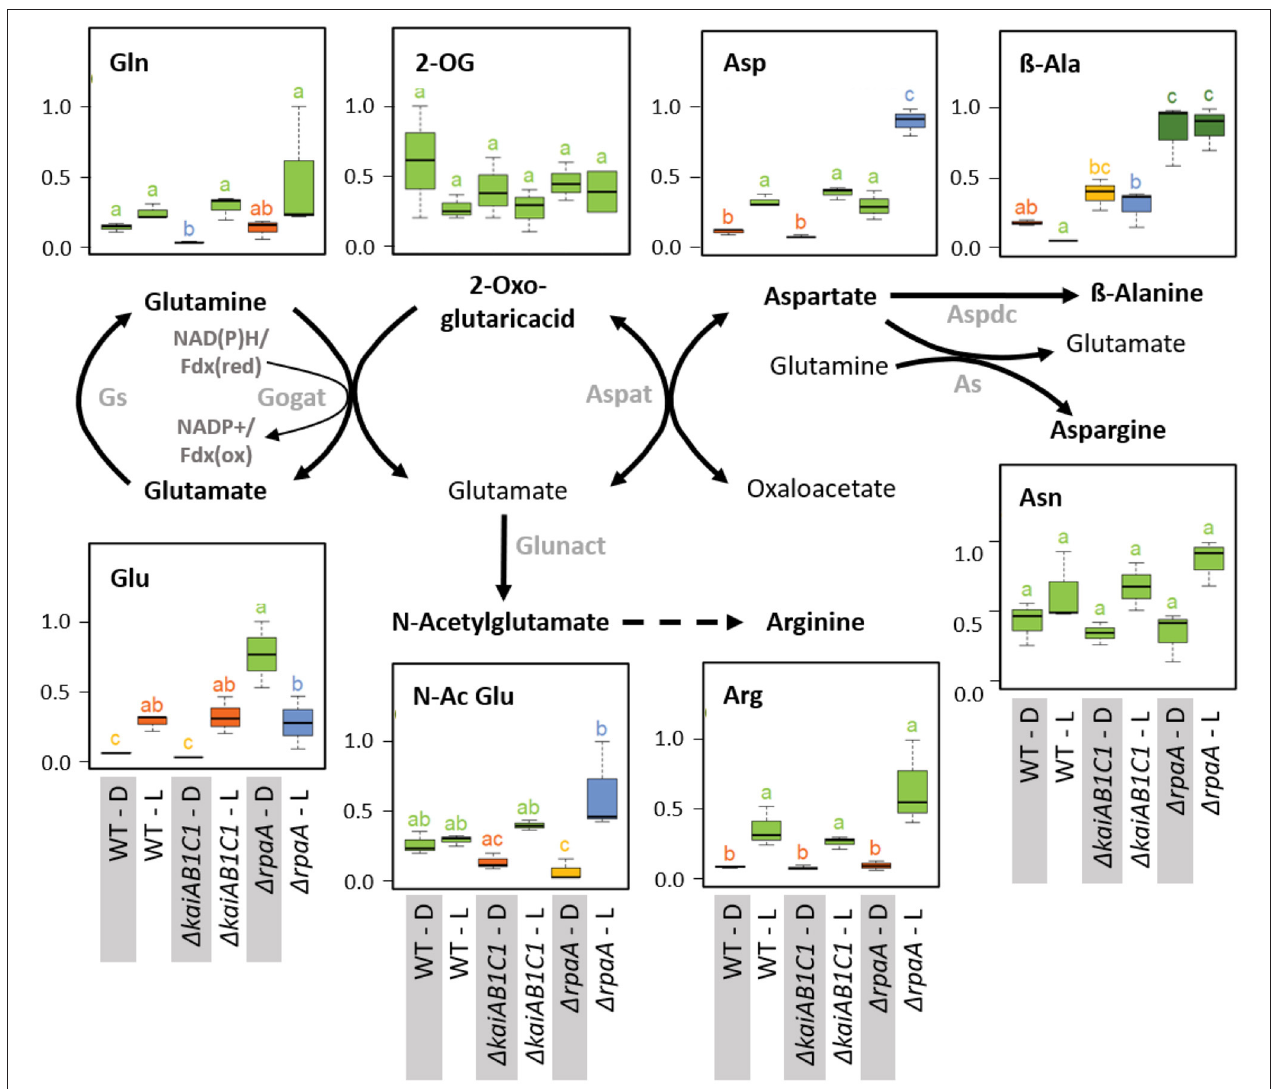
FIGURE 11 | Nitrogen assimilation and associated amino acid biosynthesis. Box plots showing the maximum normalized relative changes in the metabolite concentrations and Tukey test results ( P < 0.05, n = 3). Metabolite levels that significantly differ are indicated by lowercase letters and color coding. Note the increase in aspartate and the D accumulation of glutamate in the 1 rpaA mutant. Relevant enzymes and complexes include (gray) glutamine synthetase (Gs), glutamine 2-oxoglutarate aminotransferase (Gogat), aspartate aminotransferase (Aspat), asparagine synthetase (As), aspartate decarboxylase (Aspdc), and glutamate N-acetyltransferase